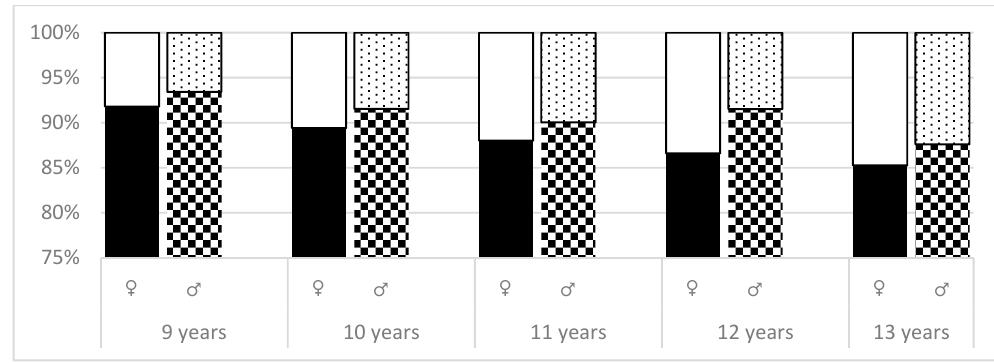
Figure 2. ATR absolute values—comparison of differences between age and sex (level 2).